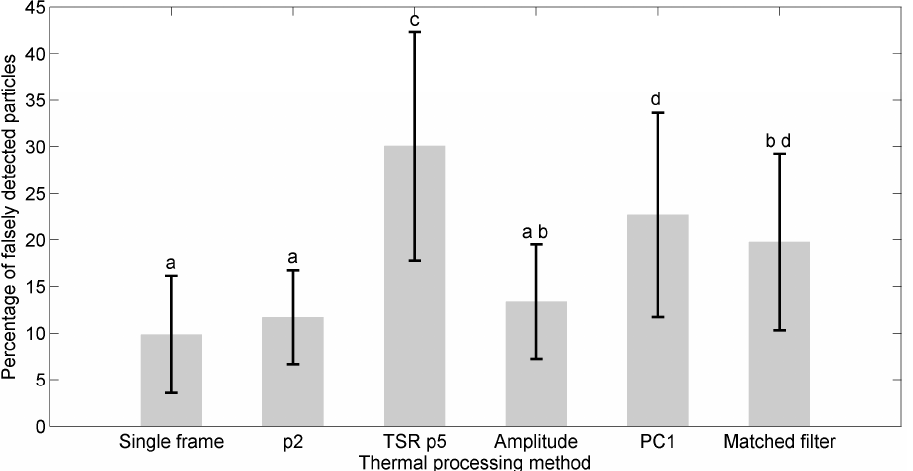
Figure 12. Mean percentage of falsely-detected particles for the six thermal output images. The error bars represent one standard deviation. A Tukey–Kramer multiple comparison test with significance level α = 0.05 was performed, and significant differences are reported in the plot.